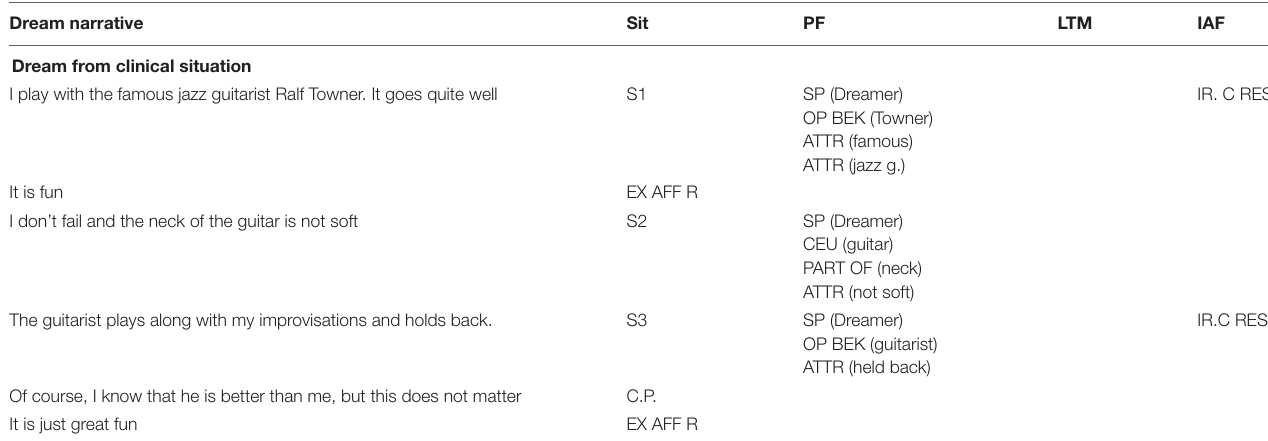
TABLE 2 | ZDPCS dream coding comparing clinical dream of the third year of psychoanalysis (Fischmann and Leuzinger-Bohleber, 2018, p. 153). Dream narrative Dream from clinical